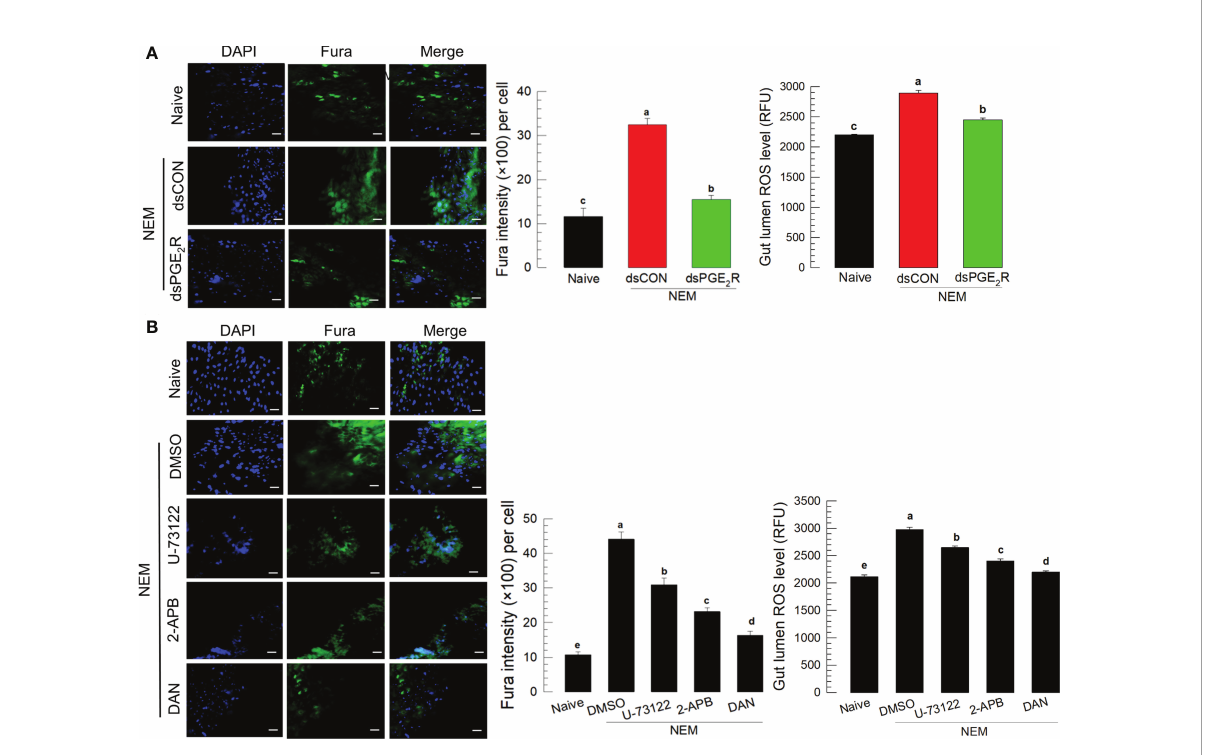
FIGURE 5 Effect of PGE 2 receptor ( ‘ PGE 2 R ’ ) and its downstream signal on the induction of Ca 2+ signal in response to gut infection by the entomopathogenic nematode ( ‘ NEM ’ ) infection. Each L5 larva of S . exigua was fed with 80 IJs of S . feltiae . (A) Effect of RNAi against Se-PGE 2 R expression on calcium signal and ROS production. NEM treatment was performed at 24 h after dsRNA (1 µg/larva) injection. (B) Inhibition of Ca 2+ signal by four different calcium signal inhibitors: dantrolene sodium ( ‘ DAN ’ , a speci fi c inhibitor to ryanodine receptor), 2-APB (a speci fi c IP 3 receptor inhibitor), U-73122 (a speci fi c PLC inhibitor) along with NEM treatment. All inhibitors were injected in a dose of 1 µg per larva. The guts of treated larvae were dissected at 8 h after the NEM or inhibitor treatment. Nuclei were stained with DAPI. Fura-8AM was used to observe Ca 2+ . Each treatment was replicated three times. The scale bar represents 10 µm. Different letters above standard error bars indicate signi fi cant difference among means at Type I error = 0.05 (LSD